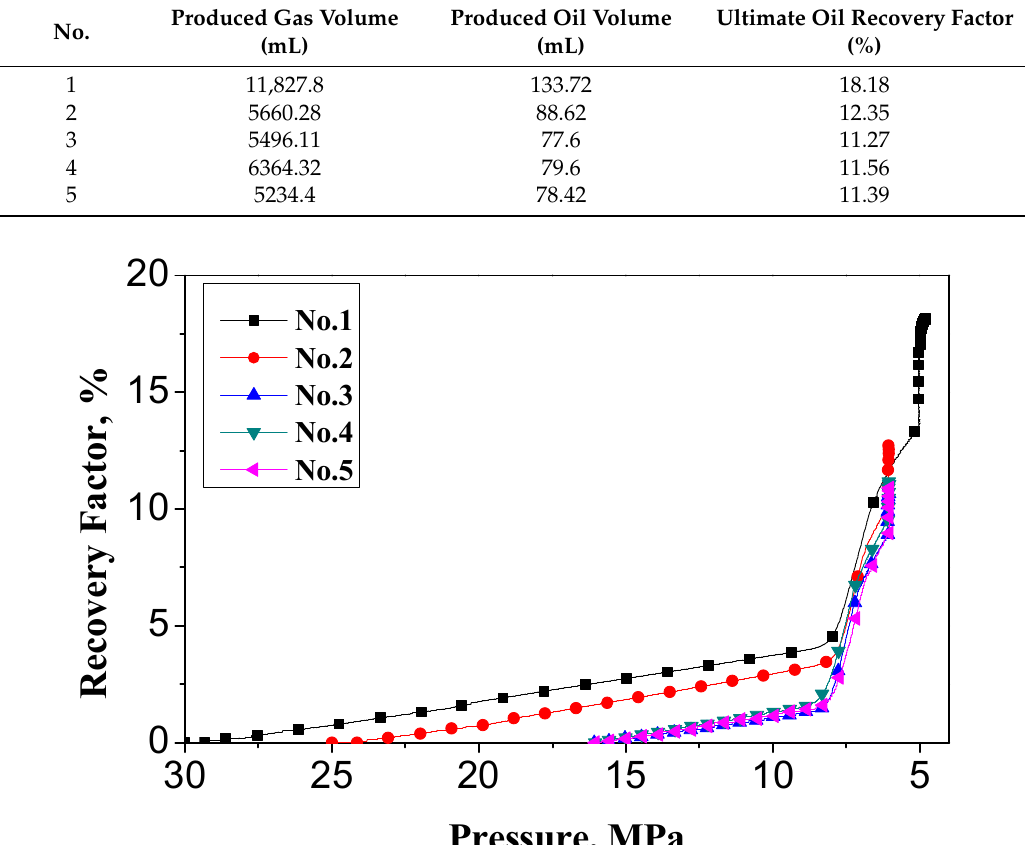
Table 8. Experimental results of live oil depletion under different initial formation pressure.